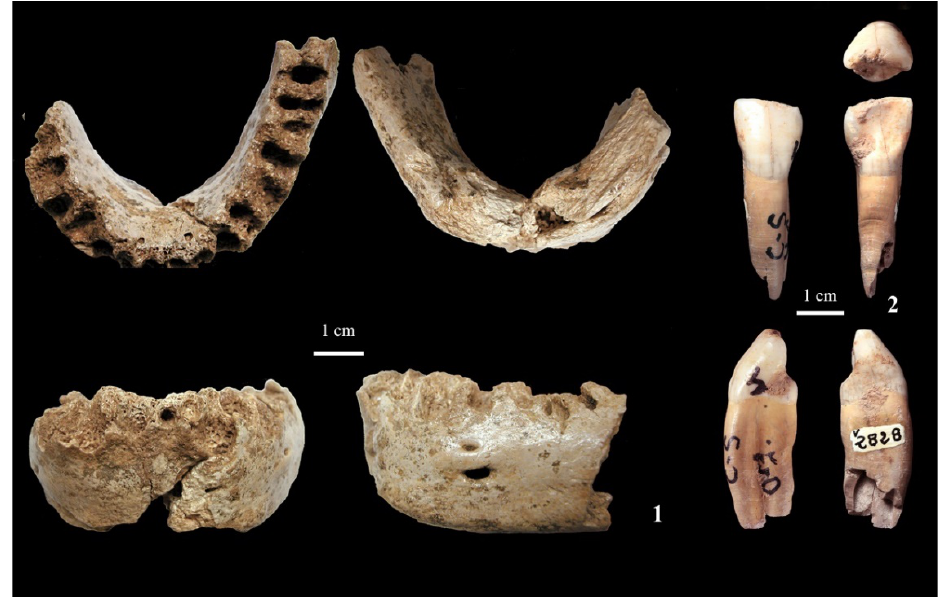
Figure 4. Neanderthal remains identified at GL1 from Cova del Gegant. ( 1 ): Different views of the adult mandible Gegant-1. ( 2 ): The lower incisor, Gegant-2, from an individual of 10 years